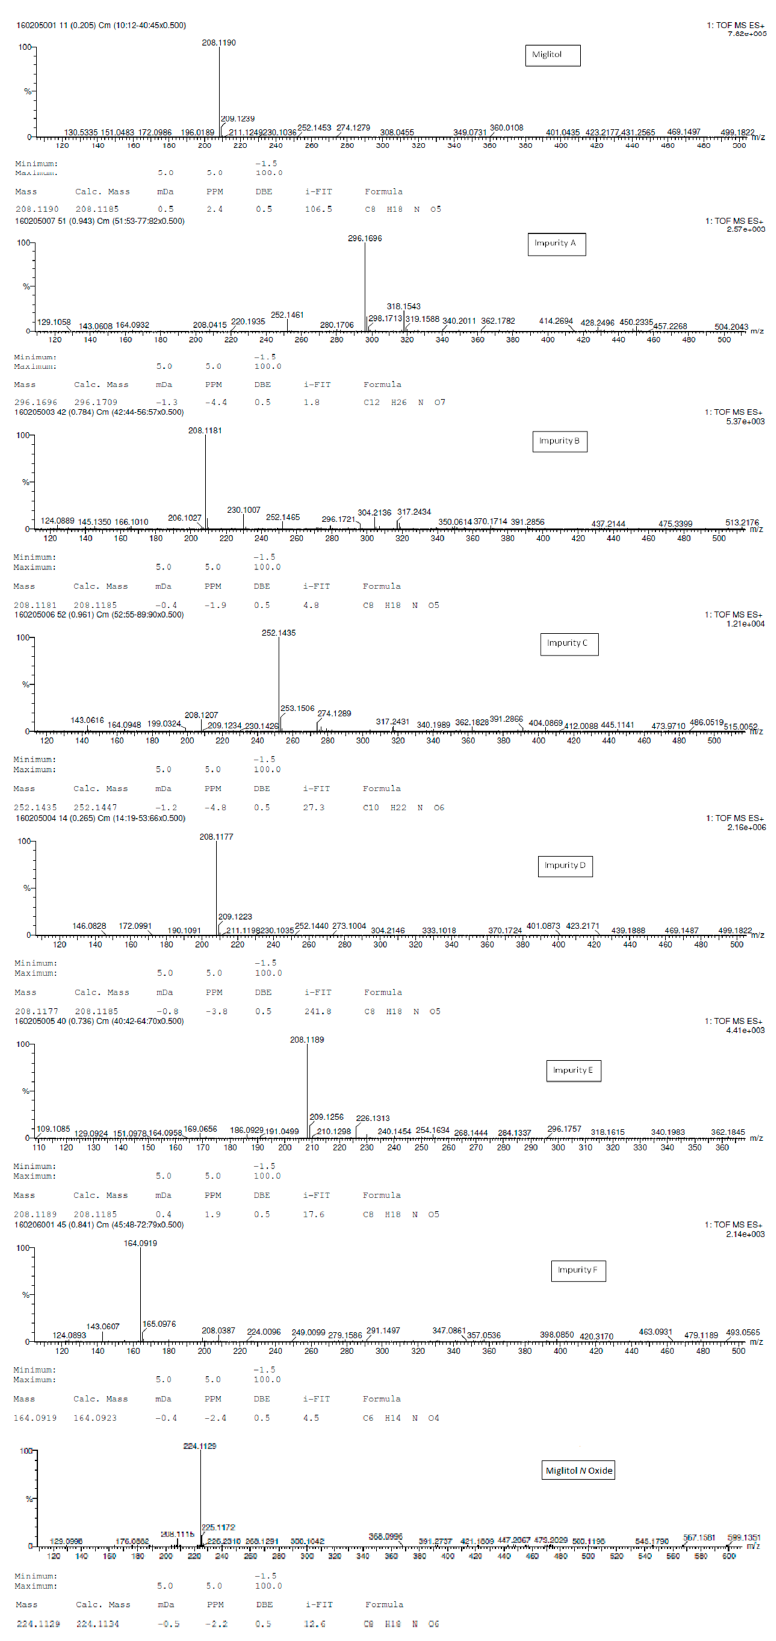
Figure 4. HRMS spectral data for miglitol and its